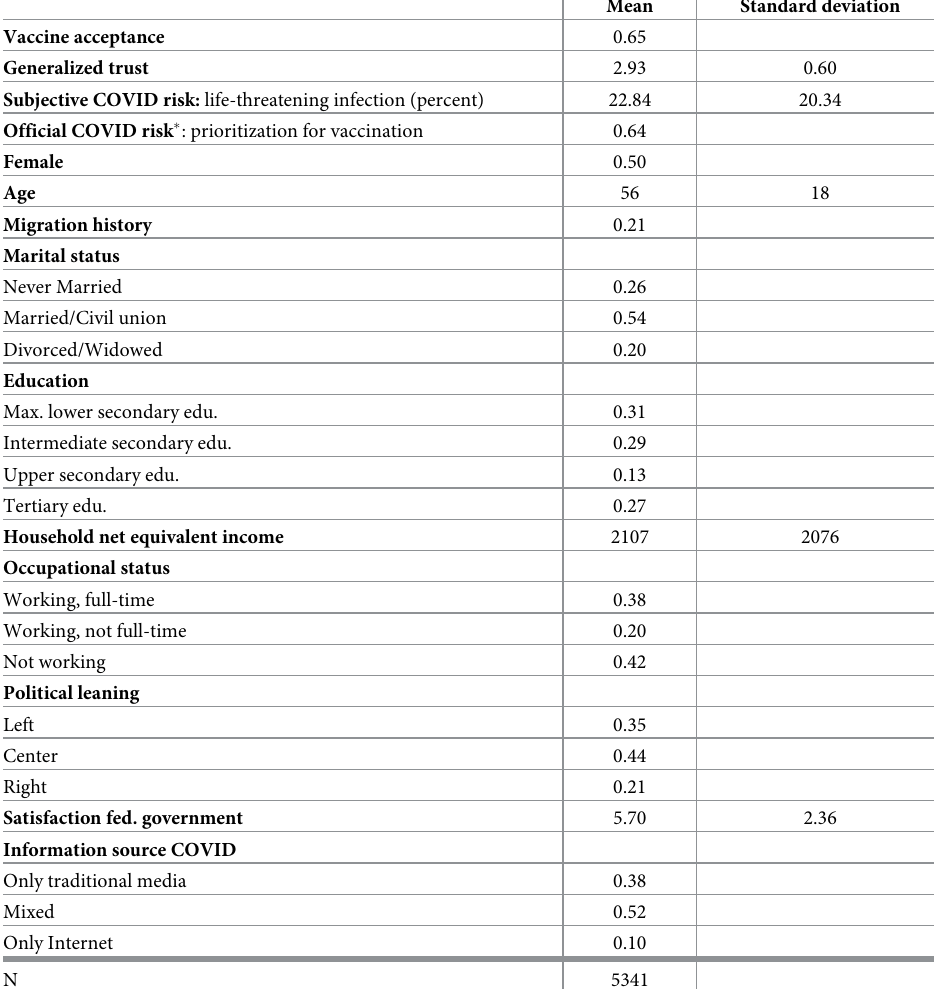
Table 1. Variable